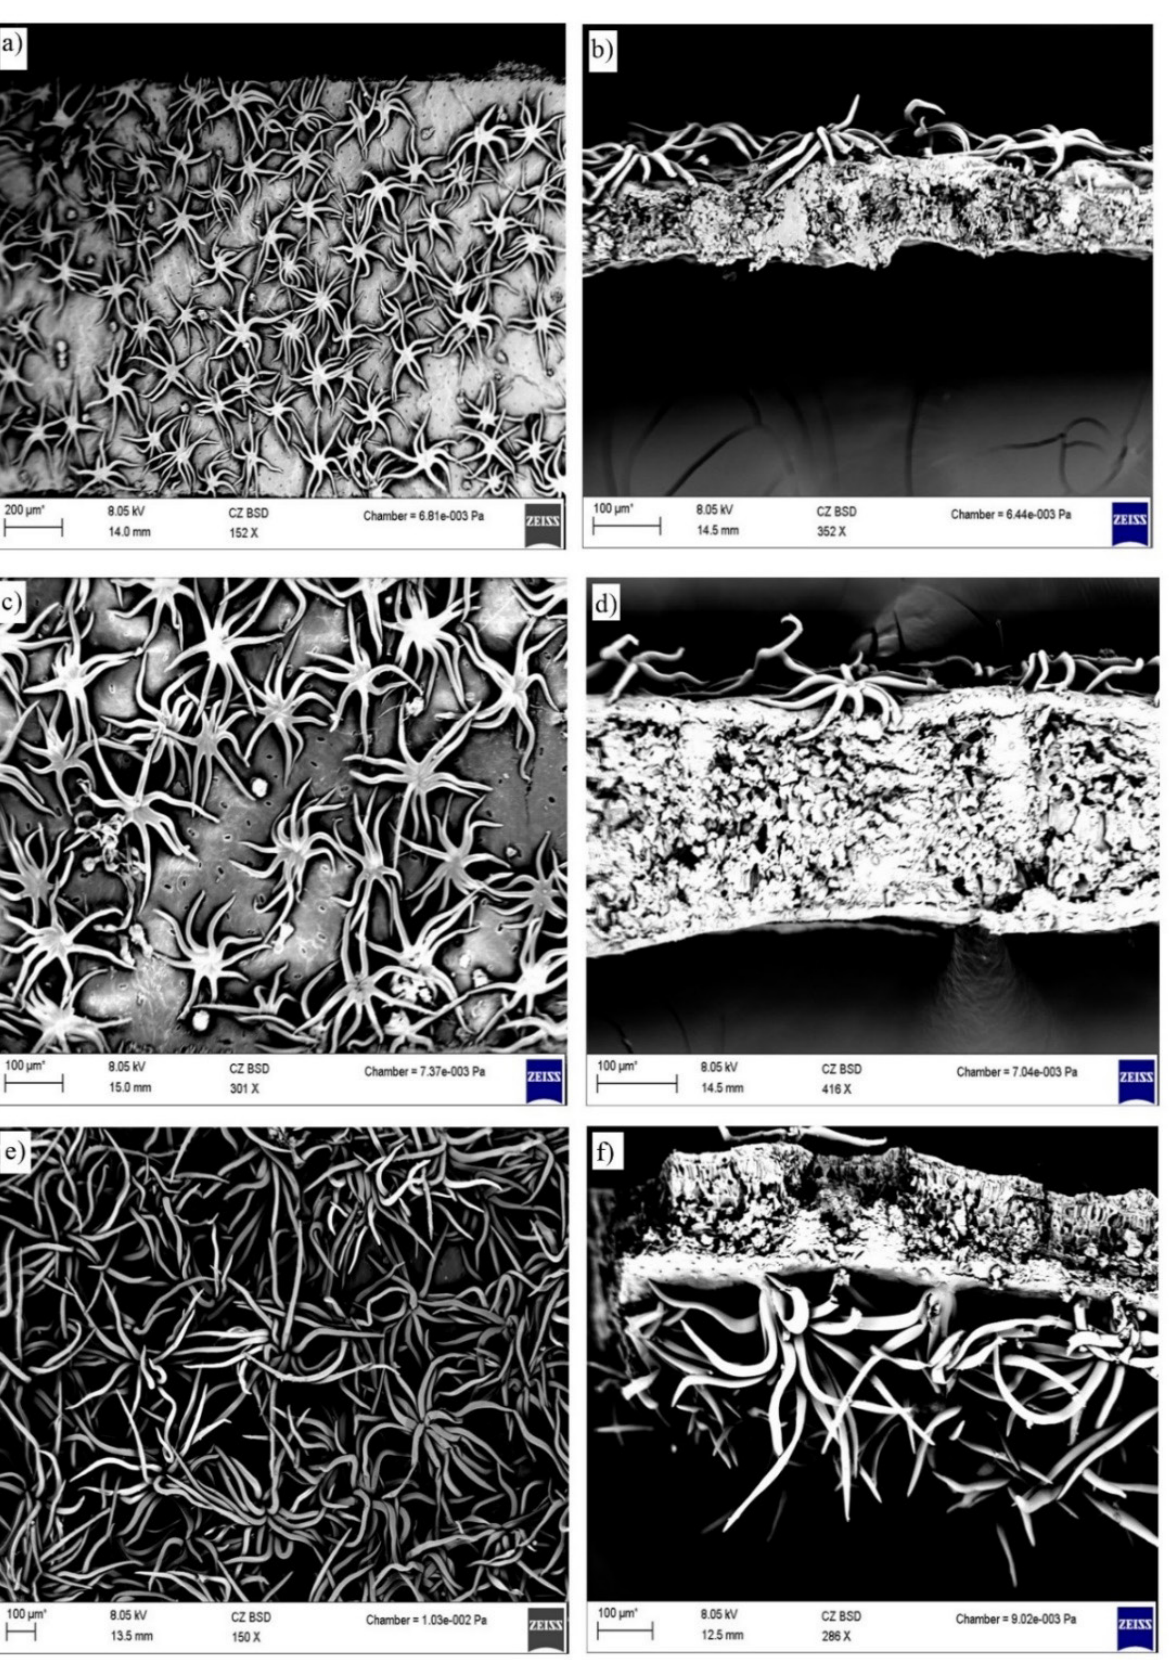
Figure 2. Trichome analysis comparison (SEM) of Iberian hybrids between kermes oak and holm oak and Quercus airensis - (a), b) - Quercus × eborense nob. ; c), d) – Q. × auzandri; e), f) – Q. airensis ); (a), c) – Detail of abaxial leaf surface with fused-stellate and stellate trichomes (152x magnifying in Q. × eborense nob. and 301x in Q. × auzandri ); (b), d) – transversal overview and detail of appressed fused-stellate and stellate indumentum (abaxial leaf surface) (352x in Q. × eborense nob. and 416x in Q. × auzandri ); (e), f) - Detail of multiradial and stipitate trichomes (e)-150x; f) - 286x) in Q. airensis with large rays (>300